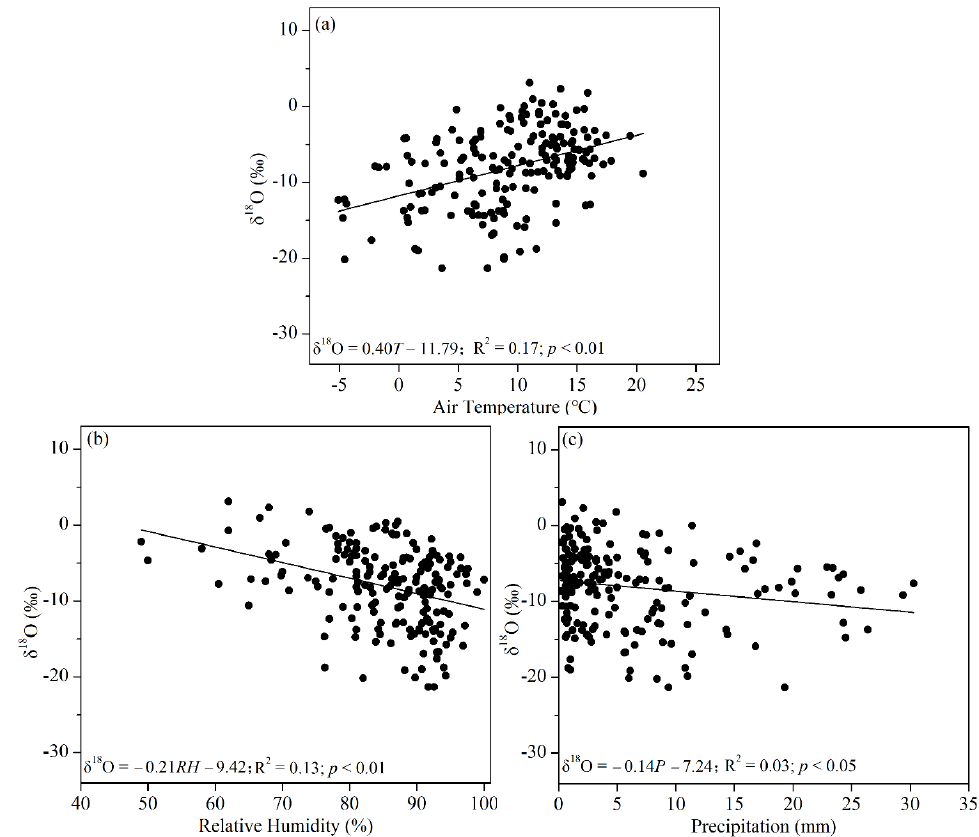
Figure 4. Correlations between δ 18 O and air temperature ( T ), precipitation amount ( P ), and relative humidity ( RH ).